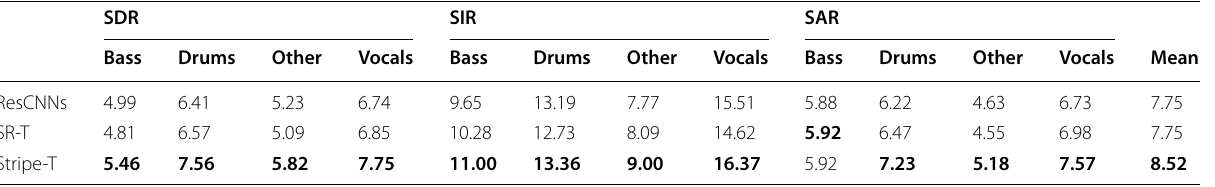
Table 1 SDR, SIR, and SAR value of U-Net-based models using different backbone networks, evaluated on the test set of Musdb18 SDR SIR Bass ResCNNs Stripe-T The best metrics are highlighted using bold font Table 2 Comparison of the experimental configuration of removing different components of the stripe-Transformer SDR